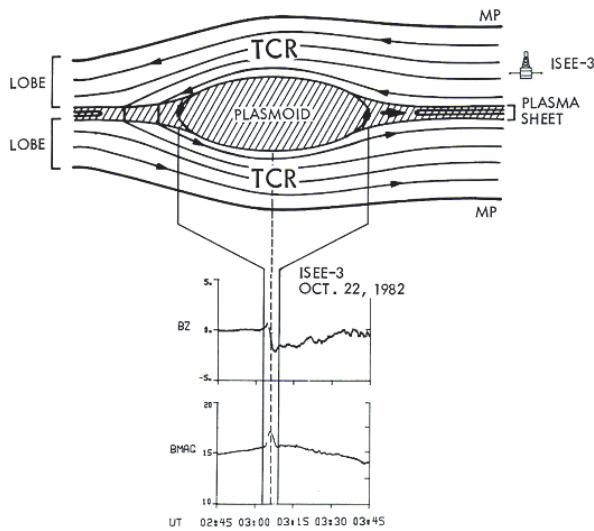
Fig. 6. A schematic view of a traveling compression region is pre- sented along with actual magnetic field magnitude and B z observed by ISEE 3 during a TCR on 22 October 1982. (Adapted from Slavin et al.,